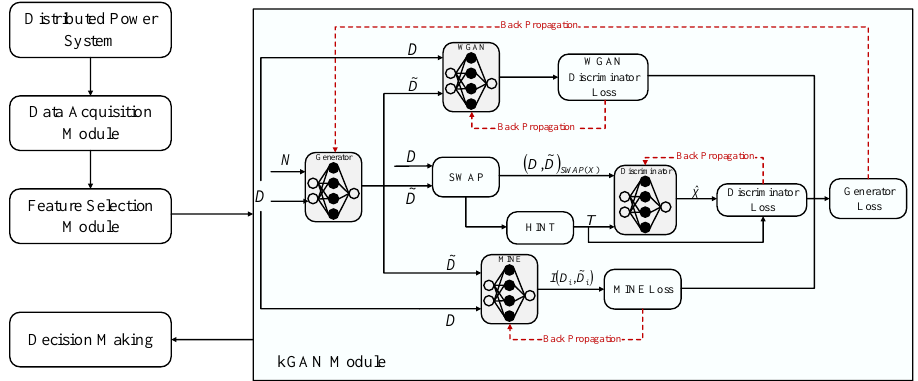
Figure 1. The general framework of the proposed diagnostic